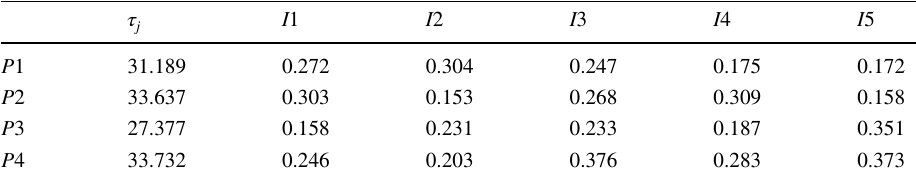
Table 7 Estimated D-CRMP parameters for case